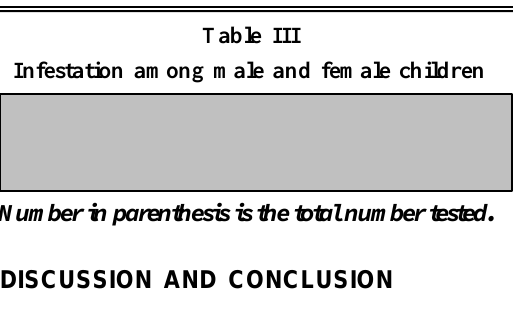
Infestation among male and female children